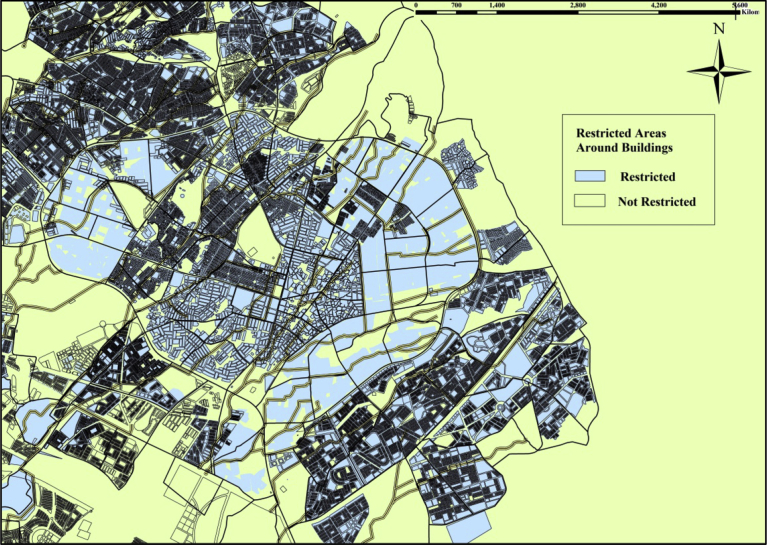
Restricted areas around the buildings.